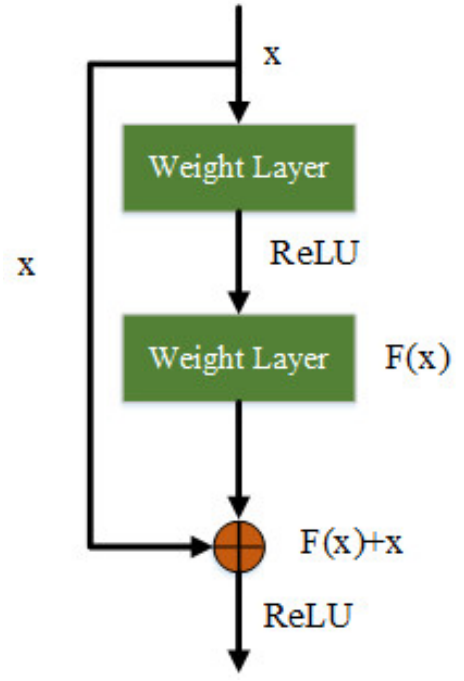
Figure 5. Schematic diagram of residual block.